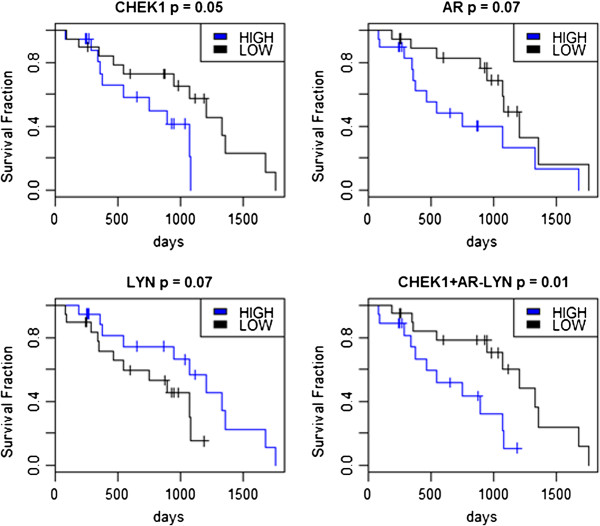
Survival curves for ovarian cancer patients designated as being either high or low expression patients for genes CHEK1, AR and LYN. The lower of the two lines in each survival plot indicates patient with poor prognosis. The combinational plot CHEK1 + AR-LYN represents the sum of the expression values of CHEK1 and AR minus the expression of LYN. The p associated with each plot gives the p-value from the log-rank test for equality between the low and high expression groups from R’s Kaplan-Meier estimate of survival.